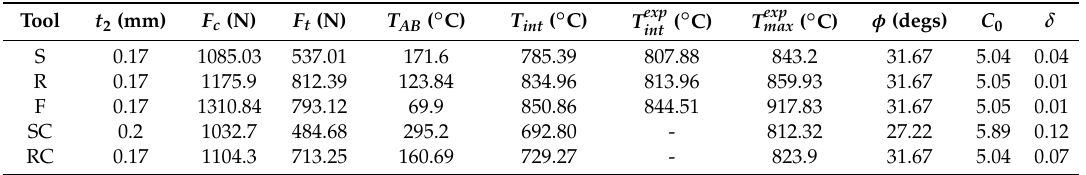
Table 6. Machining temperature predictions of AISI 4340 steel (V = 200 m/min, t 1 = 0.1 mm, w = 4.8 mm, α = 6 degs) [39].